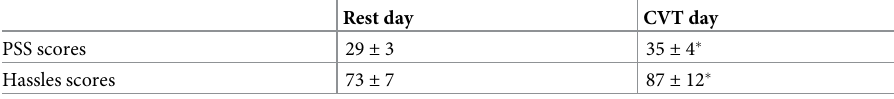
Table 2. Self-reported stress perception in the study population (n = 48).